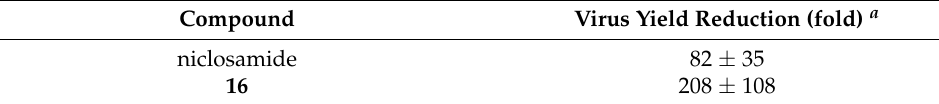
Table 2. Virus yield reduction for derivative 16.